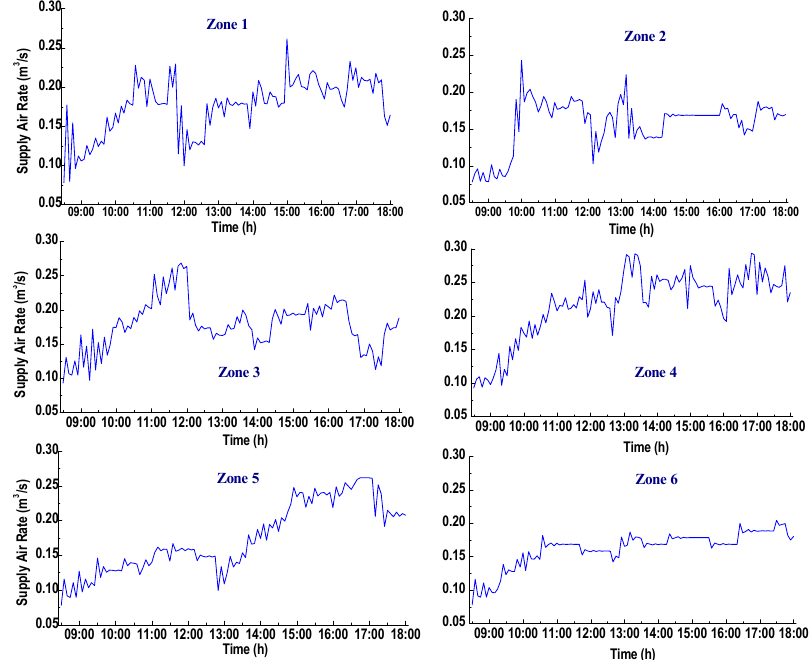
Figure 9. Supply air rate of six zones under Scenario 2.